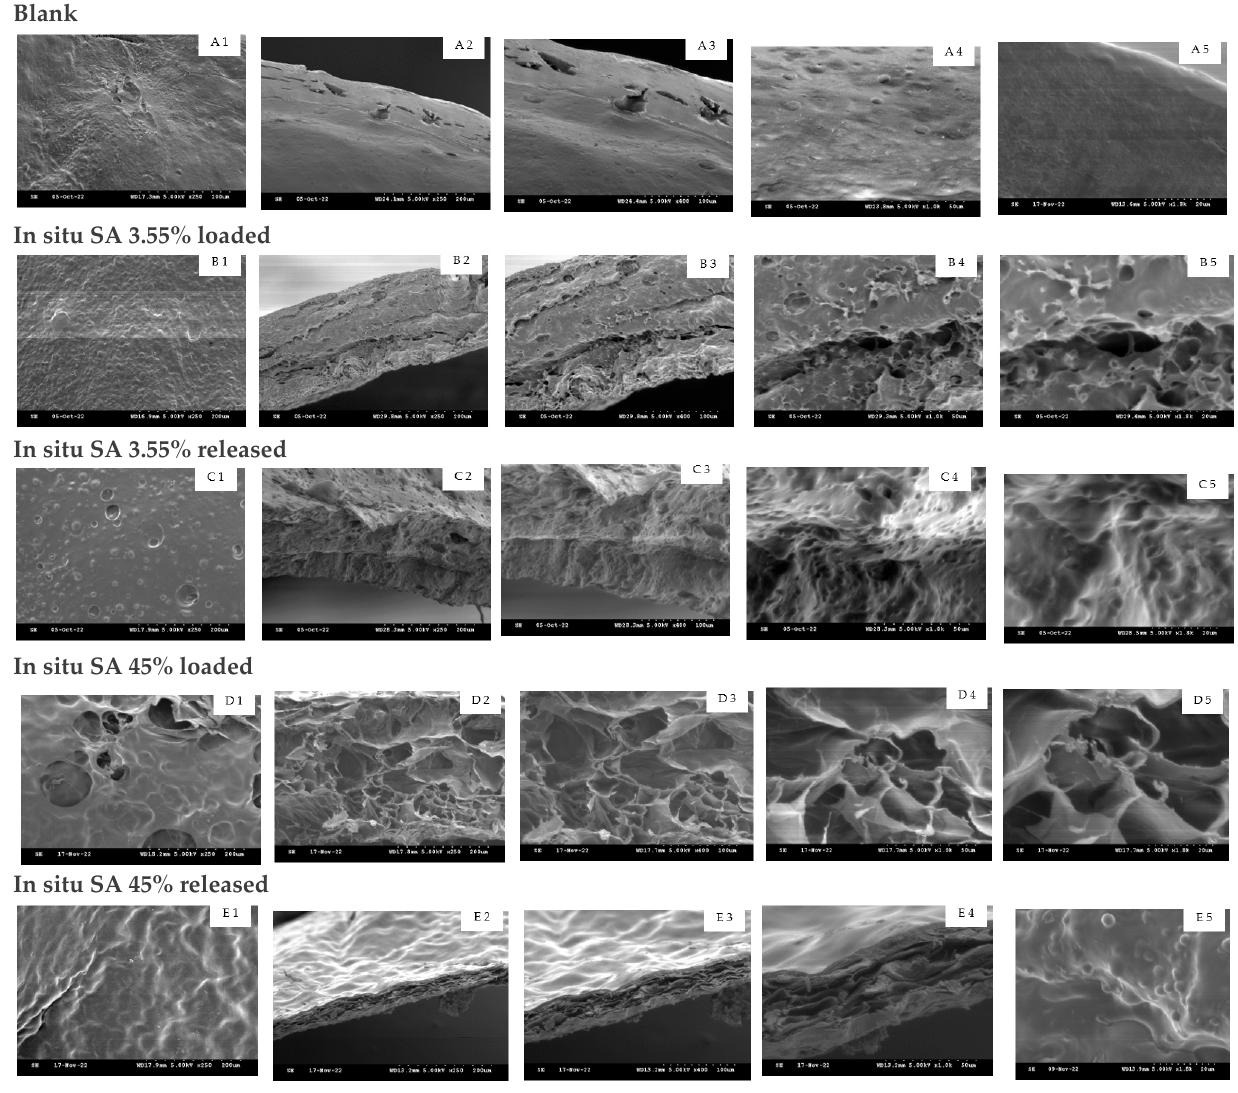
Figure 6. SEM images of the freeze-dried HA hydrogel films comparison. ( A1 – A5 ) blank (unmedi- cated) hydrogel film. ( B1 – B5 ) in situ SA 3.55% w / w loaded hydrogel film. ( C1 – C5 ) in situ SA 3.55% w / w loaded hydrogel film after release. ( D1 – D5 ) in situ SA 45% w / w loaded hydrogel film. ( E1 – E5 ) in situ SA 45% w / w loaded hydrogel film after release. The scale bars are 250 μ m surface, 250 μ m edge, 100 μ m edge, 50 μ m egde,10 μ m edge.